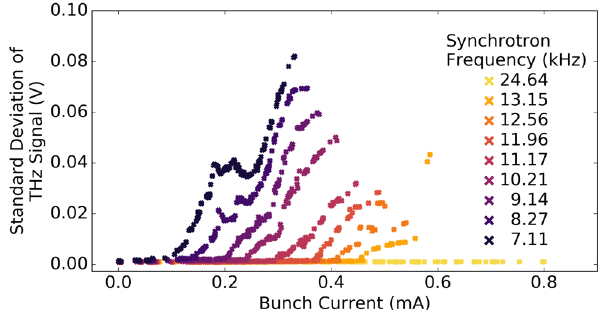
FIG. 5. Standard deviation of the THz signal as a function of the bunch current for a constant rf-voltage of 1047 kV and different settings of the magnet optics, resulting in different synchrotron frequencies and hence different bursting thresholds (adapted from [24]).